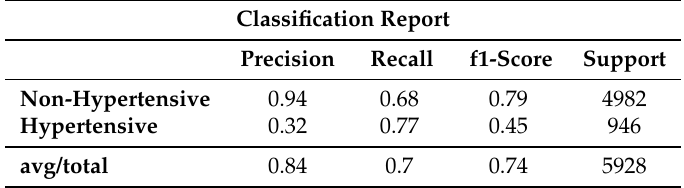
Table 12. Classification report.